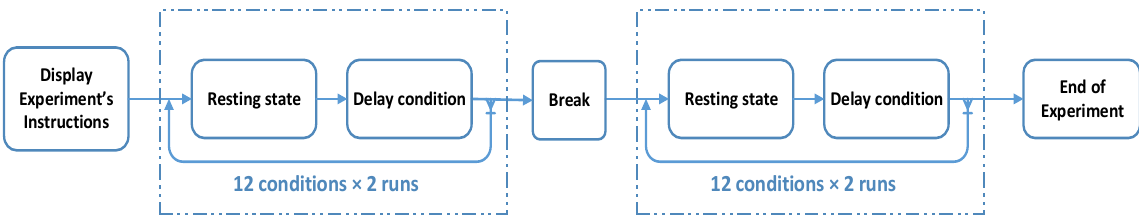
Figure 2. The block diagram of the experiment tasks and procedure. Each delay condition is displayed randomly within four condition cycles with a short break after the first two